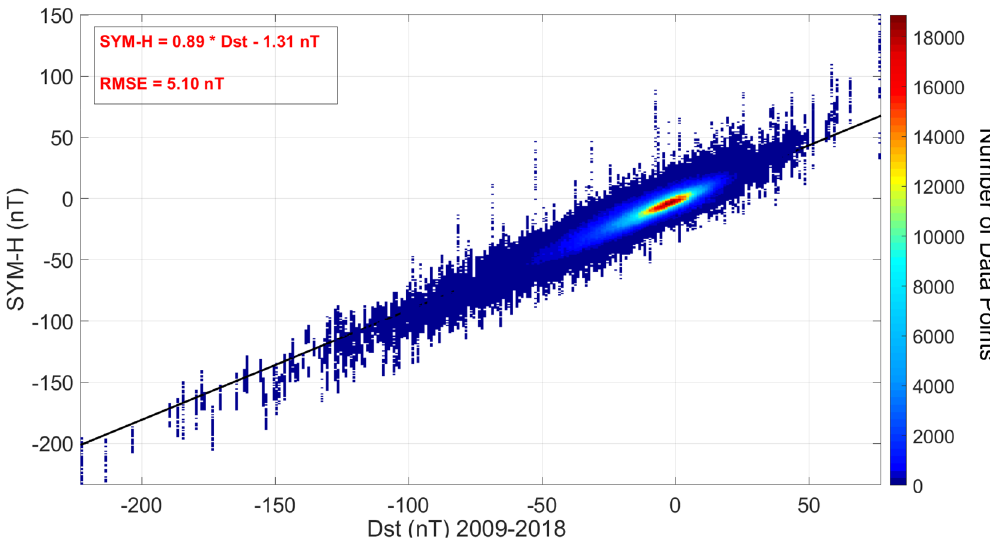
Figure 5. The Distribution of storm times SYM-H versus Dst during 2009–2018. The best fit line is shown in black and equation in